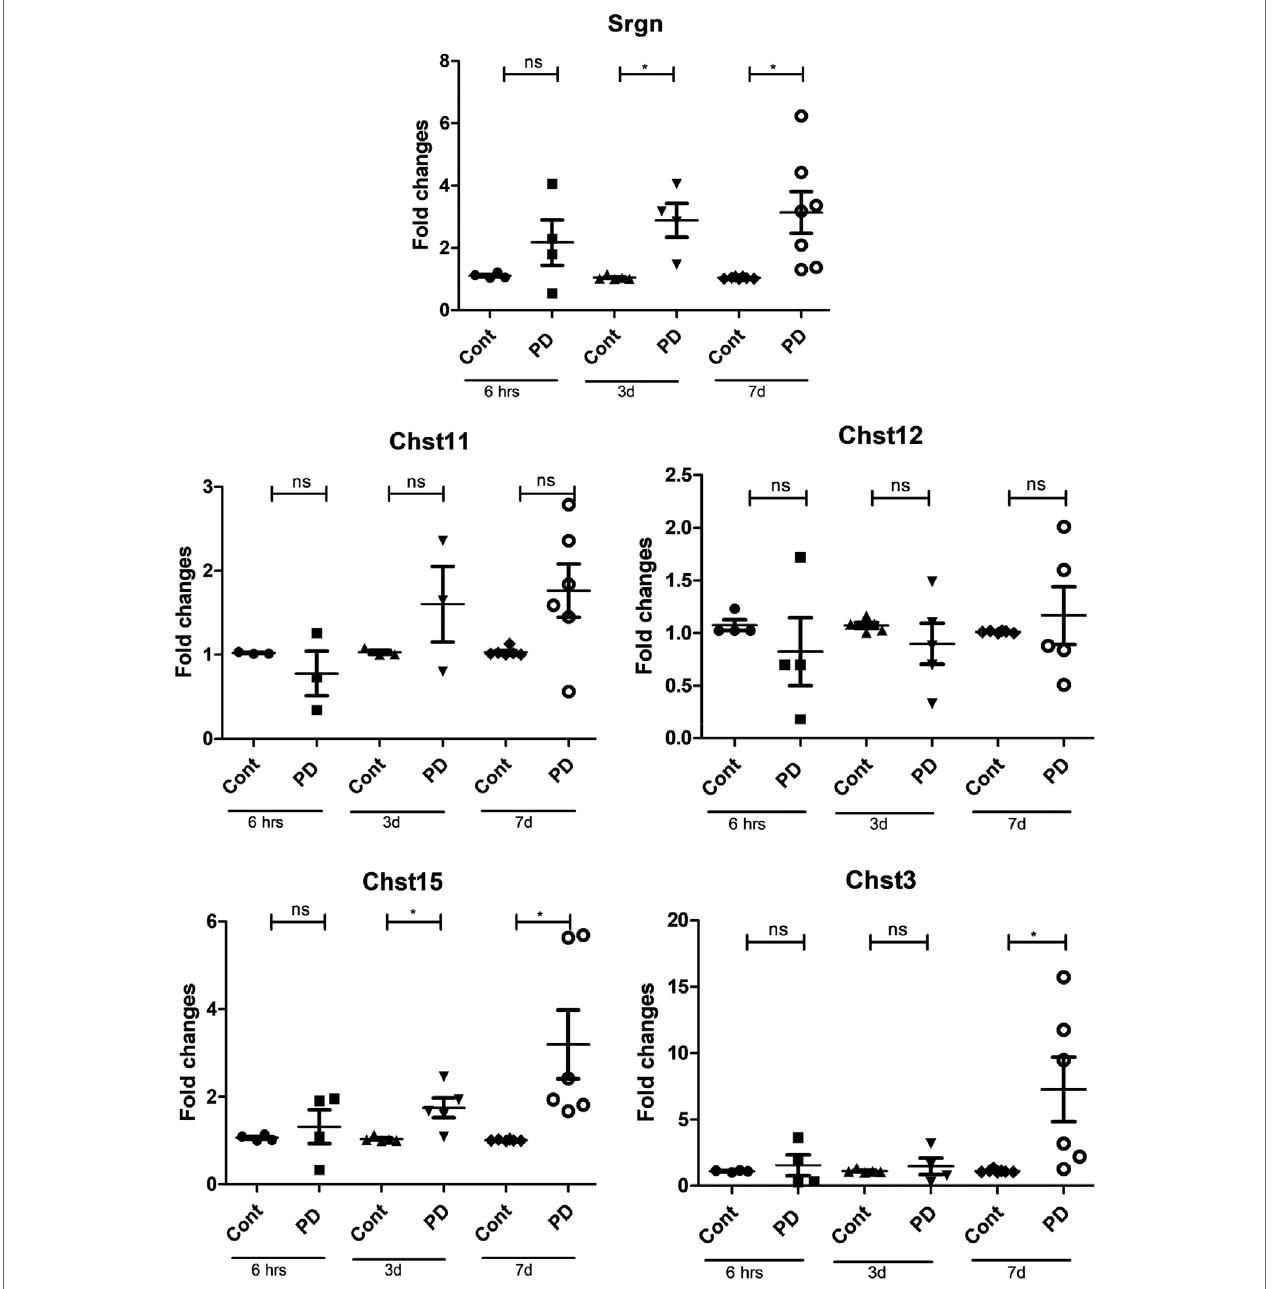
FigUre 2 | Inhibition of mitogen-activated protein kinase signaling causes increased expression of serglycin and genes involved in sulfation of chondroitin sulfate. Bone marrow-derived mast cells (0.5–1.0 × 10 6 cells/ml) were incubated with 50 µM PD98059 (PD) for various time periods (6 h–7 days) as indicated. Total RNA was then prepared and analyzed by qPCR for the expression of serglycin (Srgn), Chst11, Chst12, Chst15, and Chst3 as indicated ( n ≥ 4). Data were pooled from all experiments; at least four biological replicate experiments were performed, and each experiment was performed in triplicates (* p ≤ 0.05, ** p ≤ 0.01, *** p ≤